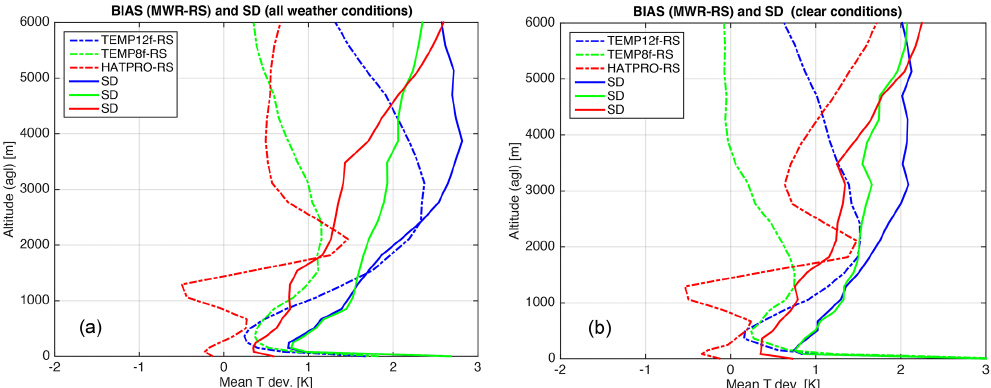
Figure 7. Mean (dashed-dotted lines) and standard temperature deviation (solid lines) between HATPRO/TEMPERA radiometers and RSs for all weather conditions (a) and clear skies (b)